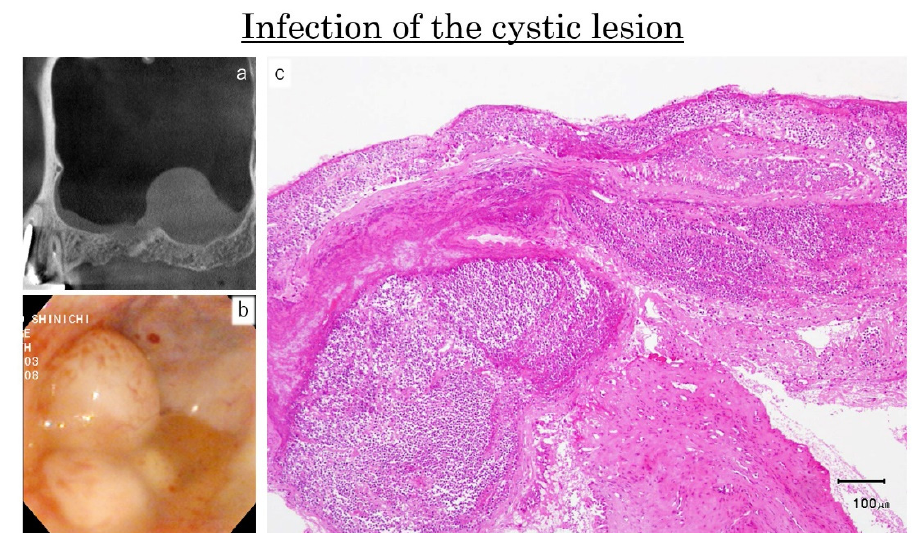
Figure 12. Case: 49 years old male. At the CBCT evaluation, the presence of a single cyst was assessed ( a ). However, at the endoscopic evaluation, one transparent and three opaque small cysts were detected ( b ). The histological specimen of the opaque cyst showed marked infiltration of the inflammatory cells and the transformation of the ciliated columnar epithelial cells into the squamous cells ( c ).